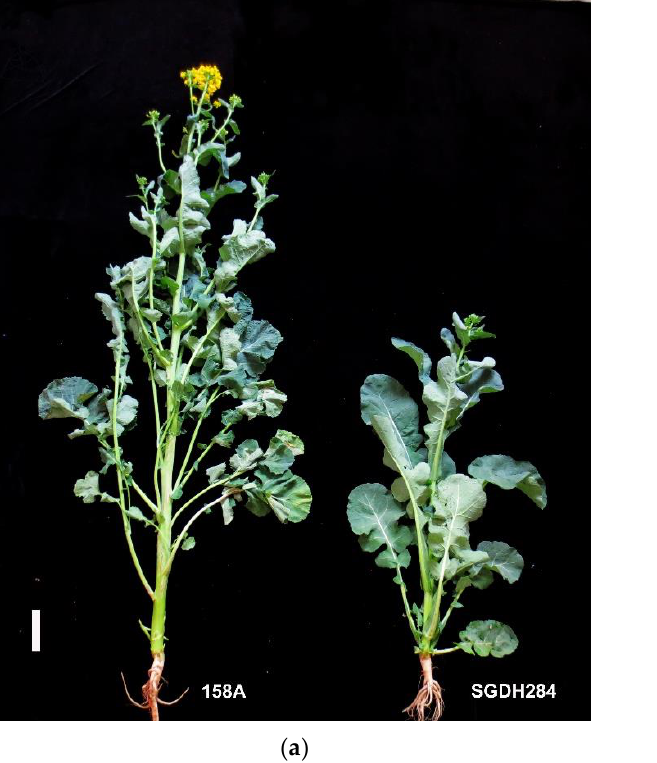
Figure 1. Phenotype of early-flowering parent 158A and late-flowering parent SGDH284 of Brassica napus in 2020. ( a ) A phenotypic picture taken on 152 days after sowing in a semi-winter rape environment. At this time, the early flowering parent 158A had already bloomed. ( b ) A phenotypic picture of a semi-winter rapeseed environment at 159 days after sowing, when the late-flowering parent SGDH284 began to bloom. Ruler = 10 cm.